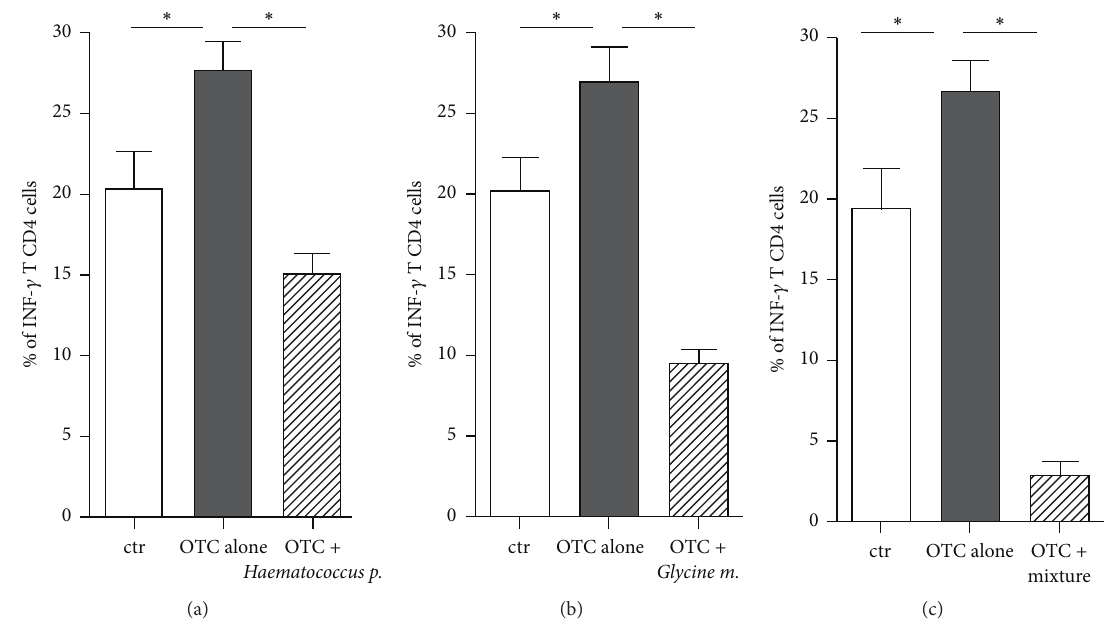
Figure 3: Statistic representation of the INF- 𝛾 production in human CD4 + T Lymphocytes after the OTC exposure and the contrasting effects after botanicals challenge in 10 representative experiments. (a) Haematococcus p. ; (b) Glycine m. ; and (c) the mixture of all the botanicals. Cytokine production was evaluated as percentage of INF- 𝛾 producing T CD4 + cells. All the incubations (basal, OTC alone, and OTC + botanical) were performed in the ad hoc medium based on the vehicle used to solubilize the botanical, so that the abbreviations “ctr” indicate the basal INF- 𝛾 production by PMBCs stimulated by PMA and Ionomycin and in presence of the ad hoc medium based on the same solubilizing-vehicle but free from the botanicals (see Section 2). ∗ 𝑝 < 0.05